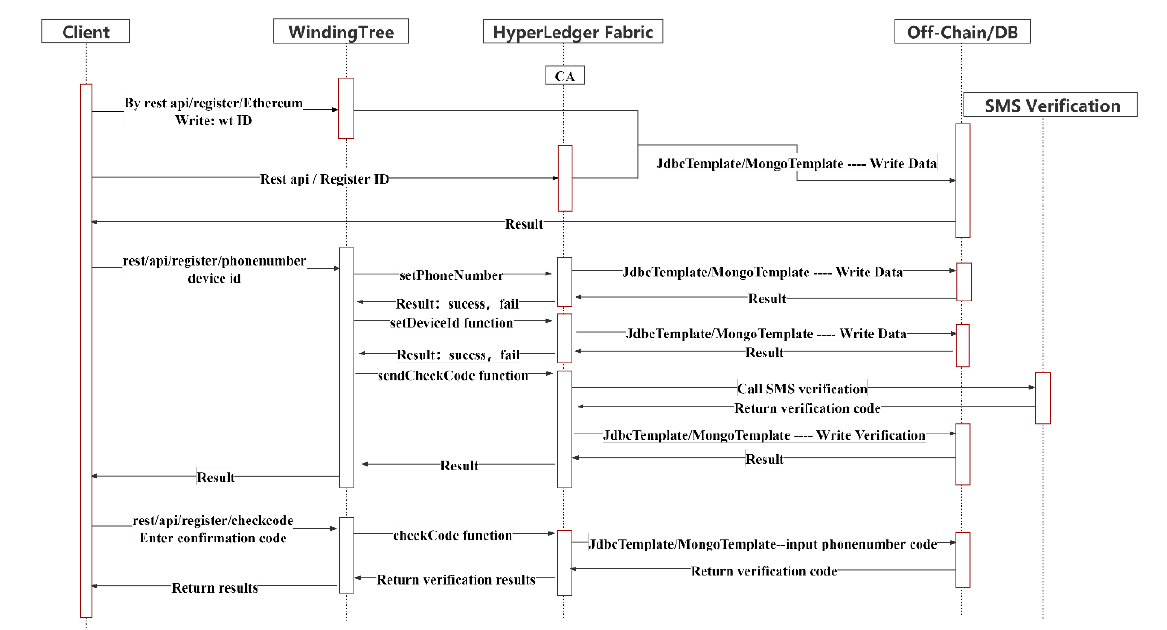
Figure 17. Execution process of user registration.